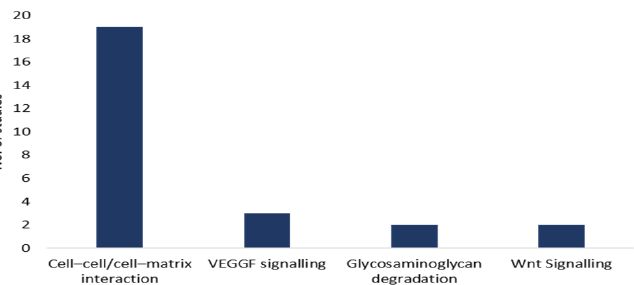
Figure 6. Commonly reported pathways/processes/groups of genes from postmortem and iPSC- based studies (Cell–cell /cell–matrix = ECM–receptor interaction, cell–matrix interaction, focal adhesion, cell adhesion molecules and cell adhesion). Table 4. Commonly reported di ff erentially expressed ECM-related gene groups/pathways/biologi- cal processes from iPSCs and postmortem tissue-based studies of PD patients compared with healthy controls (reported from, at least, two of the included studies).